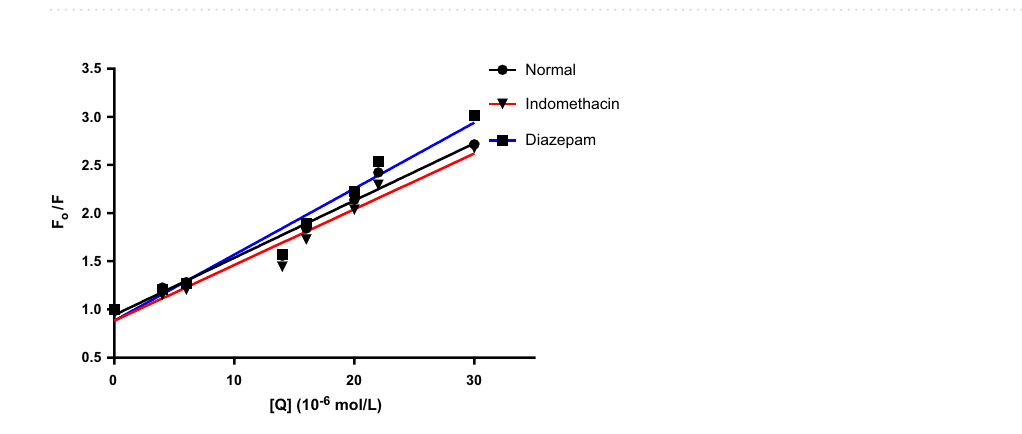
Figure 8. Synchronous fluorescence spectra of BSA (40 µM) at Δλ 60 nm in existence of MBZ (4, 5, 10, 15, 20, 25, 30, 35, 40, 45 µM).